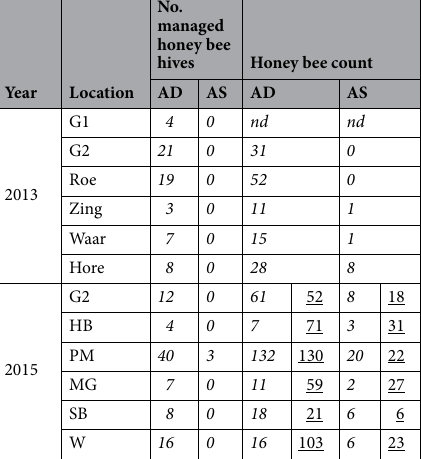
Table 1. Overview of all the locations and the number of managed honey bee hives and honey bees specimens counted in apiary dense (AD) and apiary sparse (AS) study sites. nd = not determined (pan trapping failed at this location); honey bee counts are performed by pan trapping (sum of three pan trap sets over eight weeks per study site); underlined number are counts by transect walks (sum of three 50 m transects per study